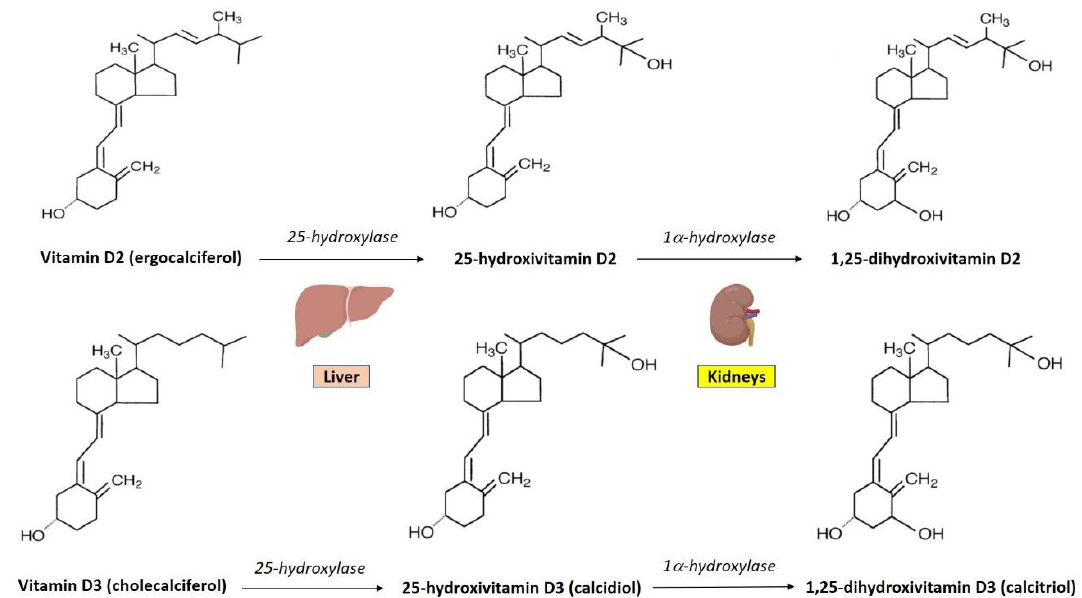
Figure 1. Chemical structure of the main forms of vitamin D and synthesis of biologically-active metabolites (1,25-dihydroxivitamin D2 and 1,25-dihydroxivitamin metabolites (1,25-dihydroxivitamin D2 and 1,25-dihydroxivitamin D3).